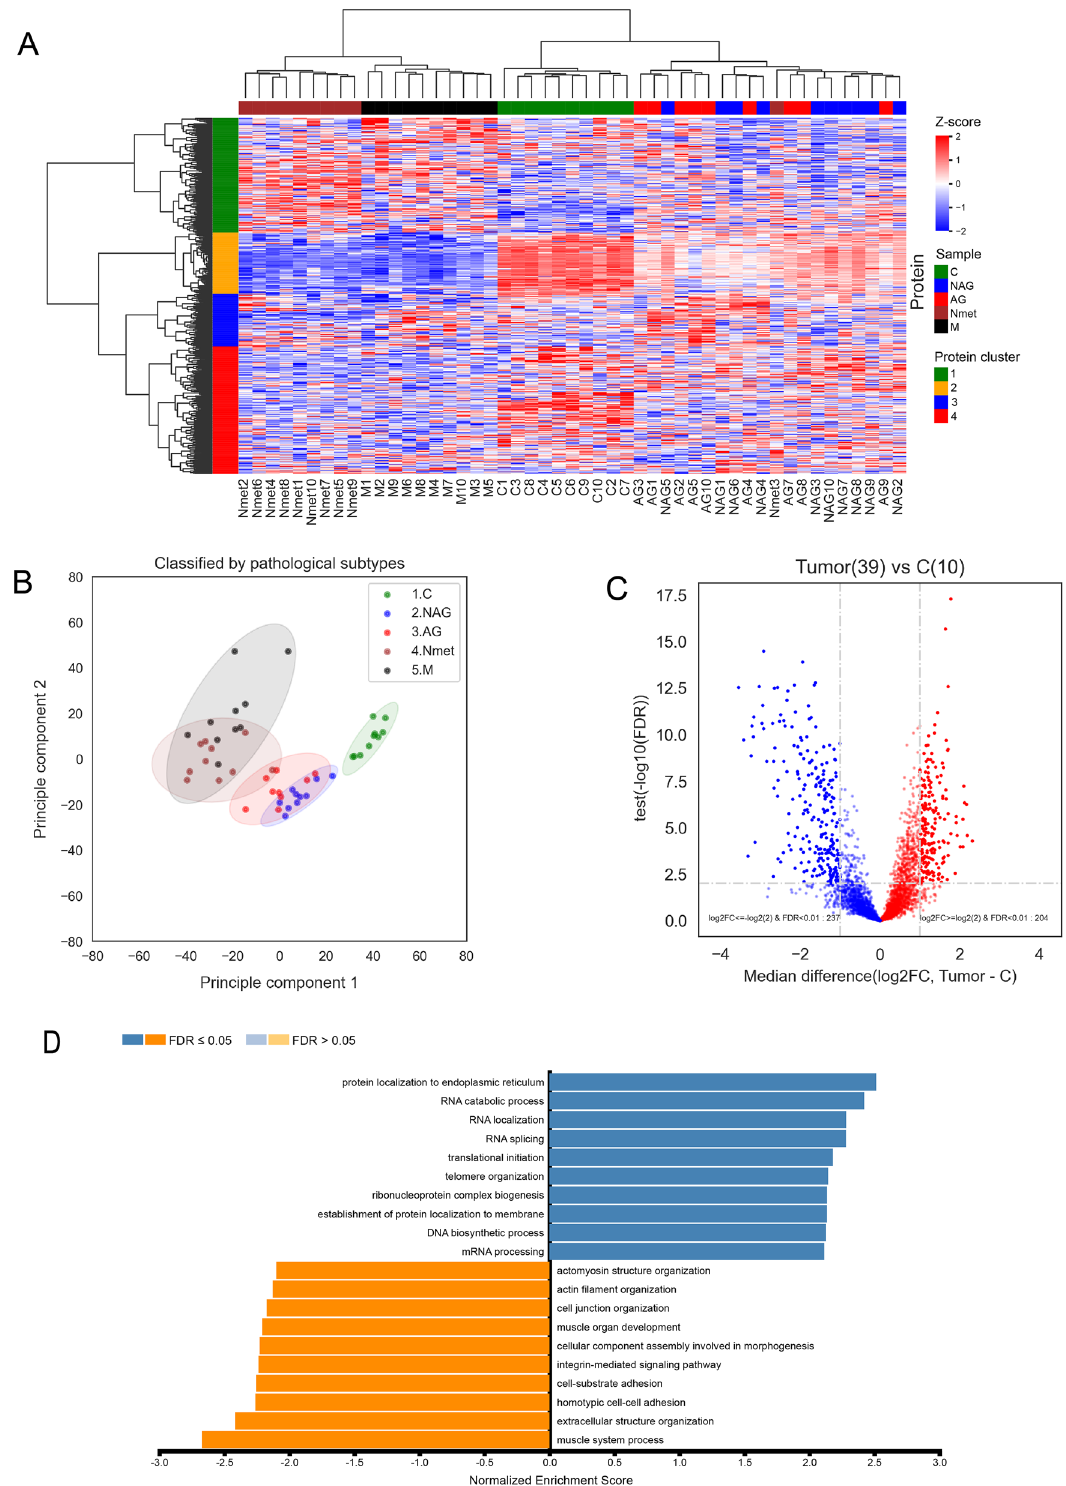
Figure 2. SWATH-MS analysis of PCa. ( A ) non-supervised hierarchical clustering of top 500 most variant proteins. Sample types were annotated by colors beyond the heat map as: NAG (blue), AG (red), Nmet (brown), M (black) and C (green). Protein clusters were labelled by colors on the left side of the heat map as: cluster 1 (green), cluster 2 (orange), cluster 3 (blue), and cluster 4 (red). ( B ) PCA analysis. ( C ) Volcano plot of significantly expressed proteins in tumors (NAG, AG, Nmet, and M groups) and controls C. ( D ) Gene set enrichment analysis (GSEA) of differentially expressed proteins based on biological process terms in the gene ontology database accessed via